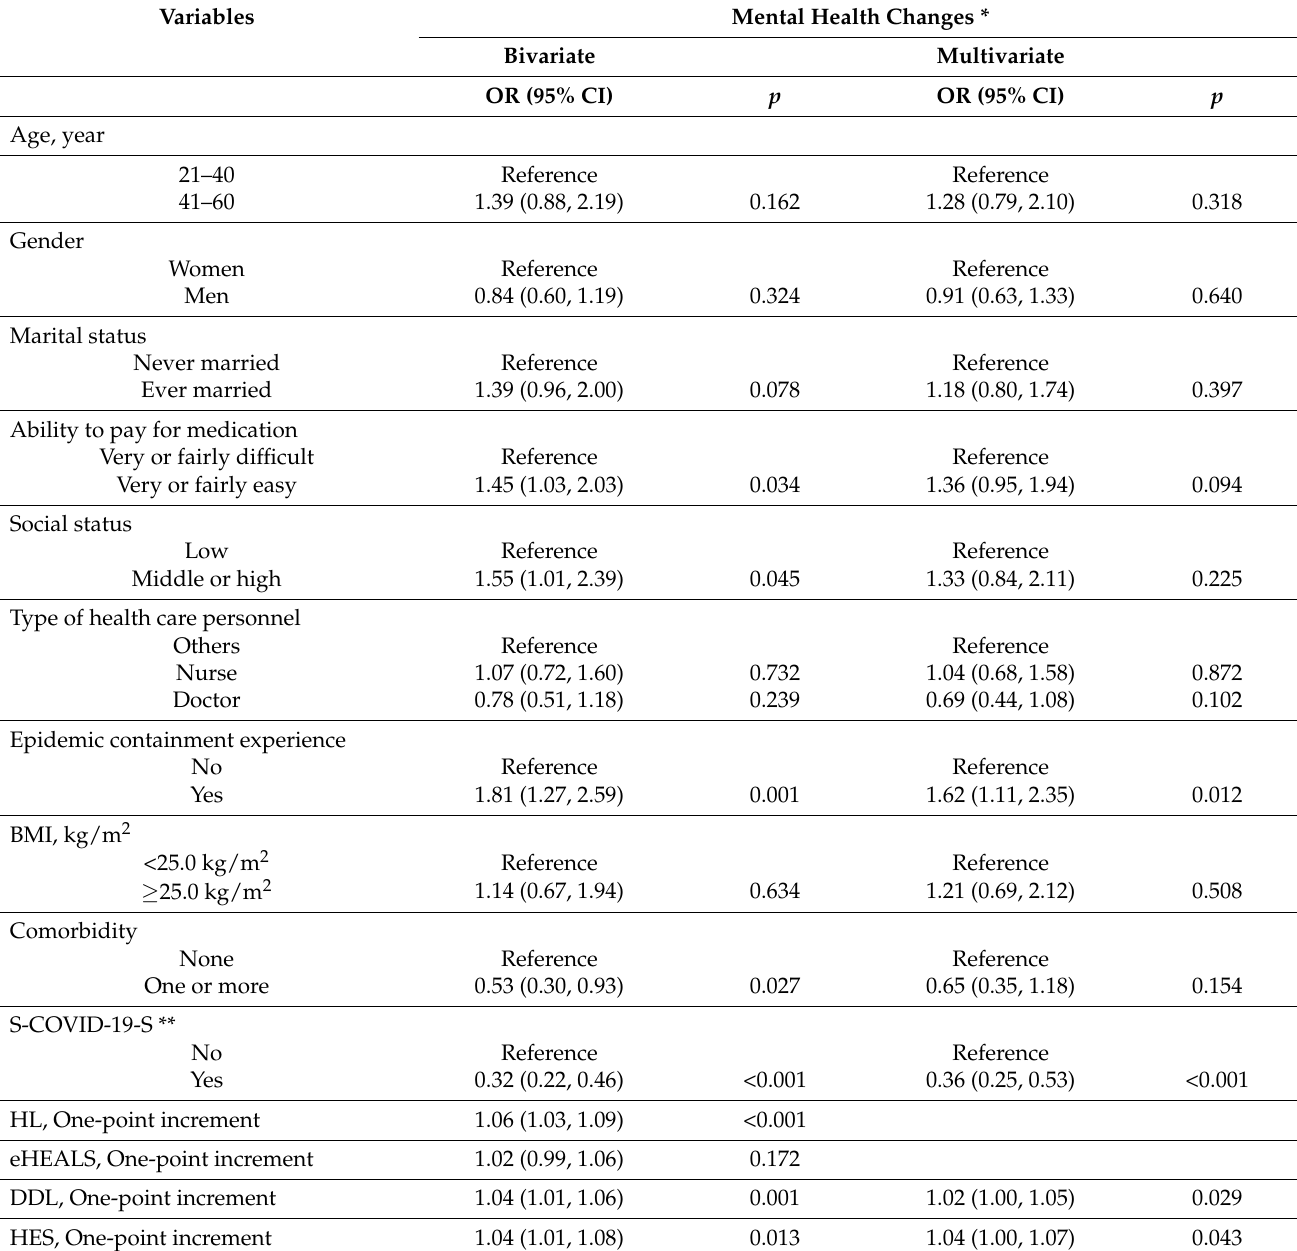
Table 3. Determinants of changes in mental health among front-line health care workers via bivariate and multivariate logistic regression models ( n =